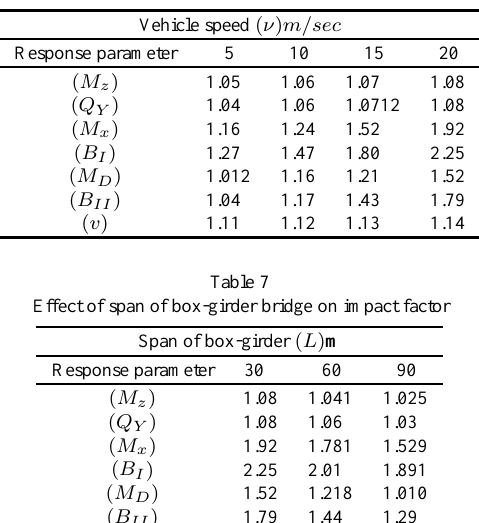
Table 6 Effect of vehicle speed on impact factor